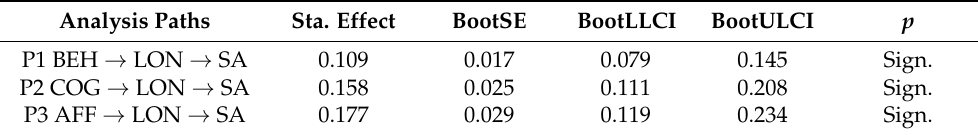
Table 4. Indirect effect of independent variables on successful